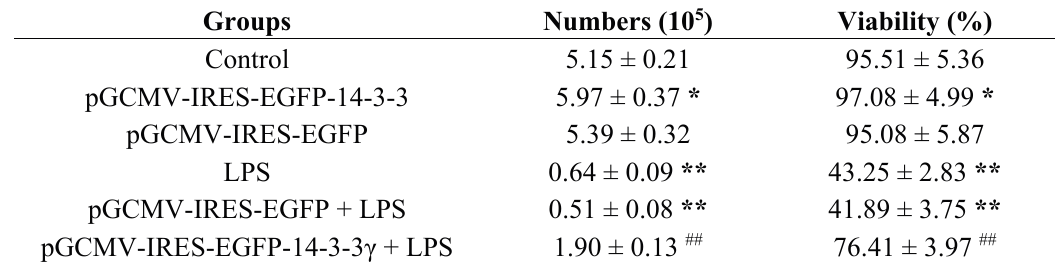
Table 1. Viability and proliferation of 14-3-3 γ overexpression on LPS-induced DCMECs.